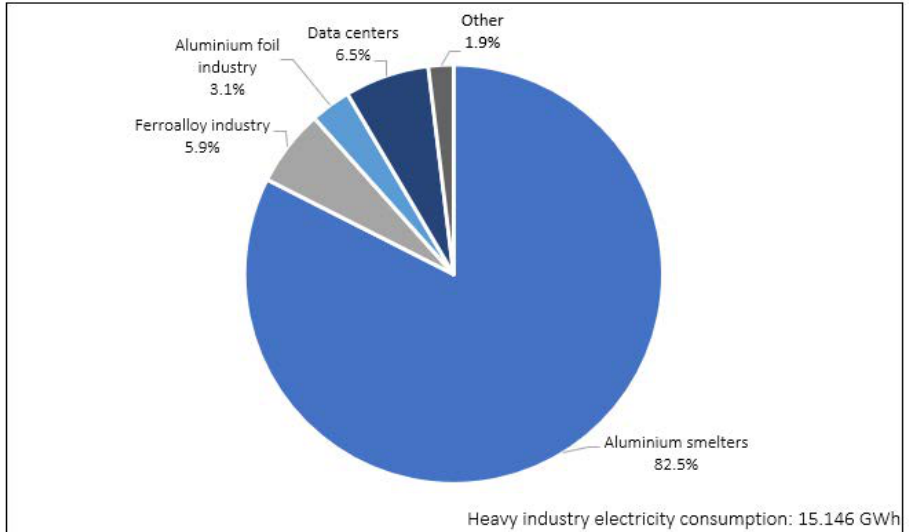
Figure 3. Heavy industry electricity consumption, by category in 2019